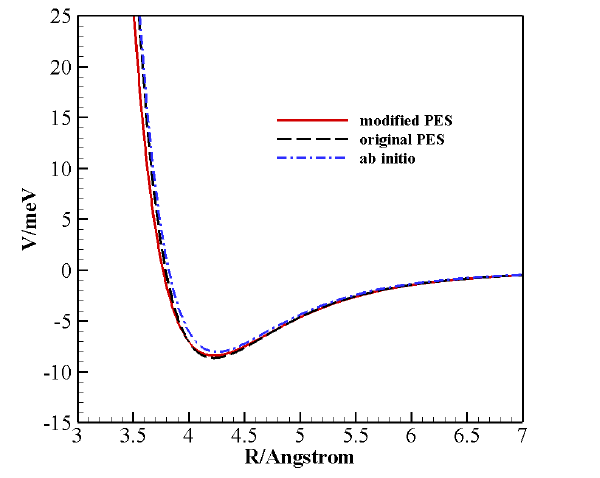
Figure 5. Spherical average of different potential energy surfaces as a function of the diatomic interaction distance. The ab initio results are those from ref.